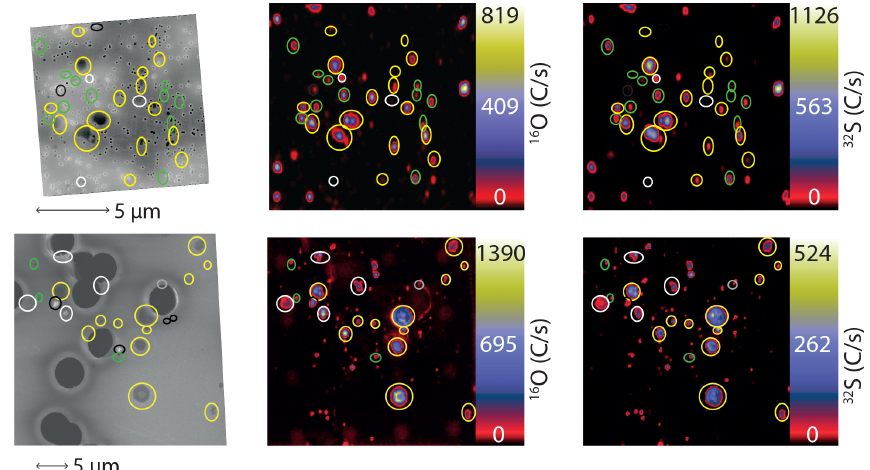
Fig. 2. SEM and NanoSIMS images of the same area on a fine (top) and coarse (bottom) particulate filter. Particles are circled with different colours according to particle type: yellow = mixed particle, green = organic aerosol, black = soot, white = soot +